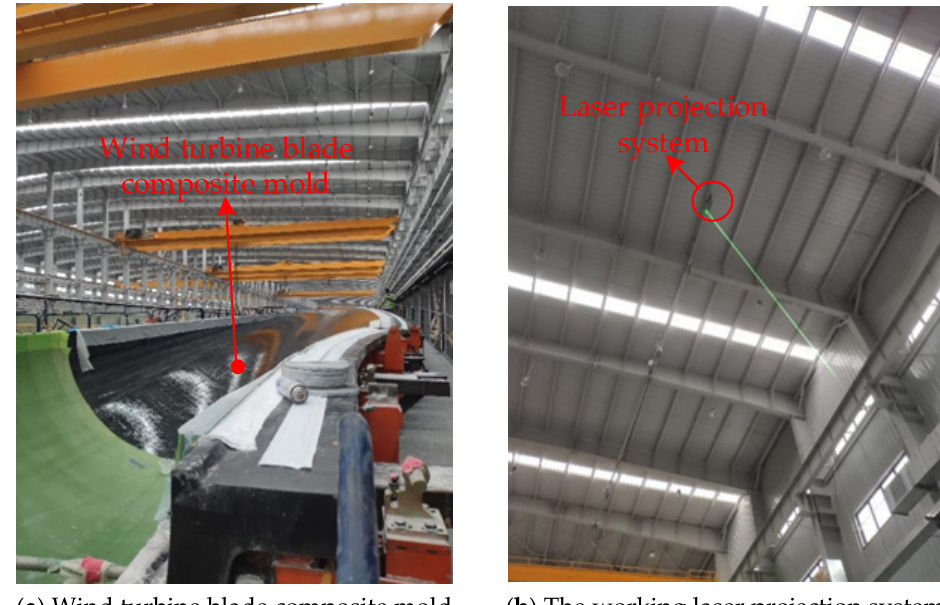
Figure 10. Large-space laser projection experiment site.